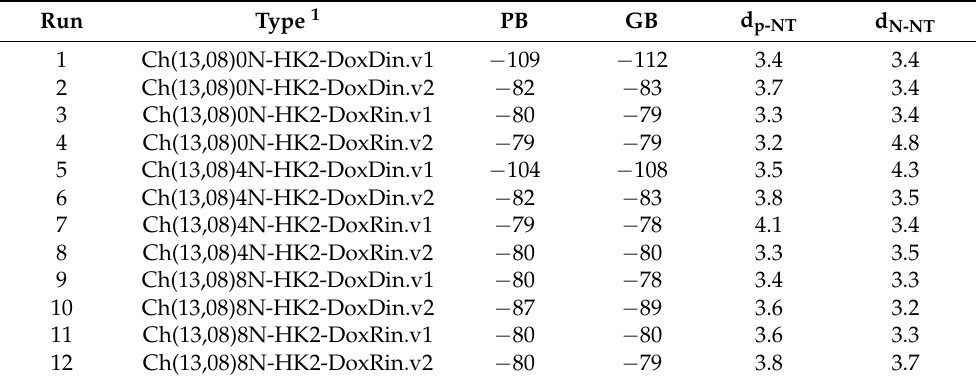
Table 2. Poisson–Boltzman (PB) and generalized bond (GB) binding energies (in kcal/mol) for the nitrogen doped and undoped chiral nanotubes (34 Å length) having two haeckelite defects, Hk2, considering encapsulated system. d p-NT are the distances from the DOX anthraquinonic plane to the nanotube wall; d N-NT is the distance from the DOX nitrogen atom to the nanotube wall. All distances are expressed in